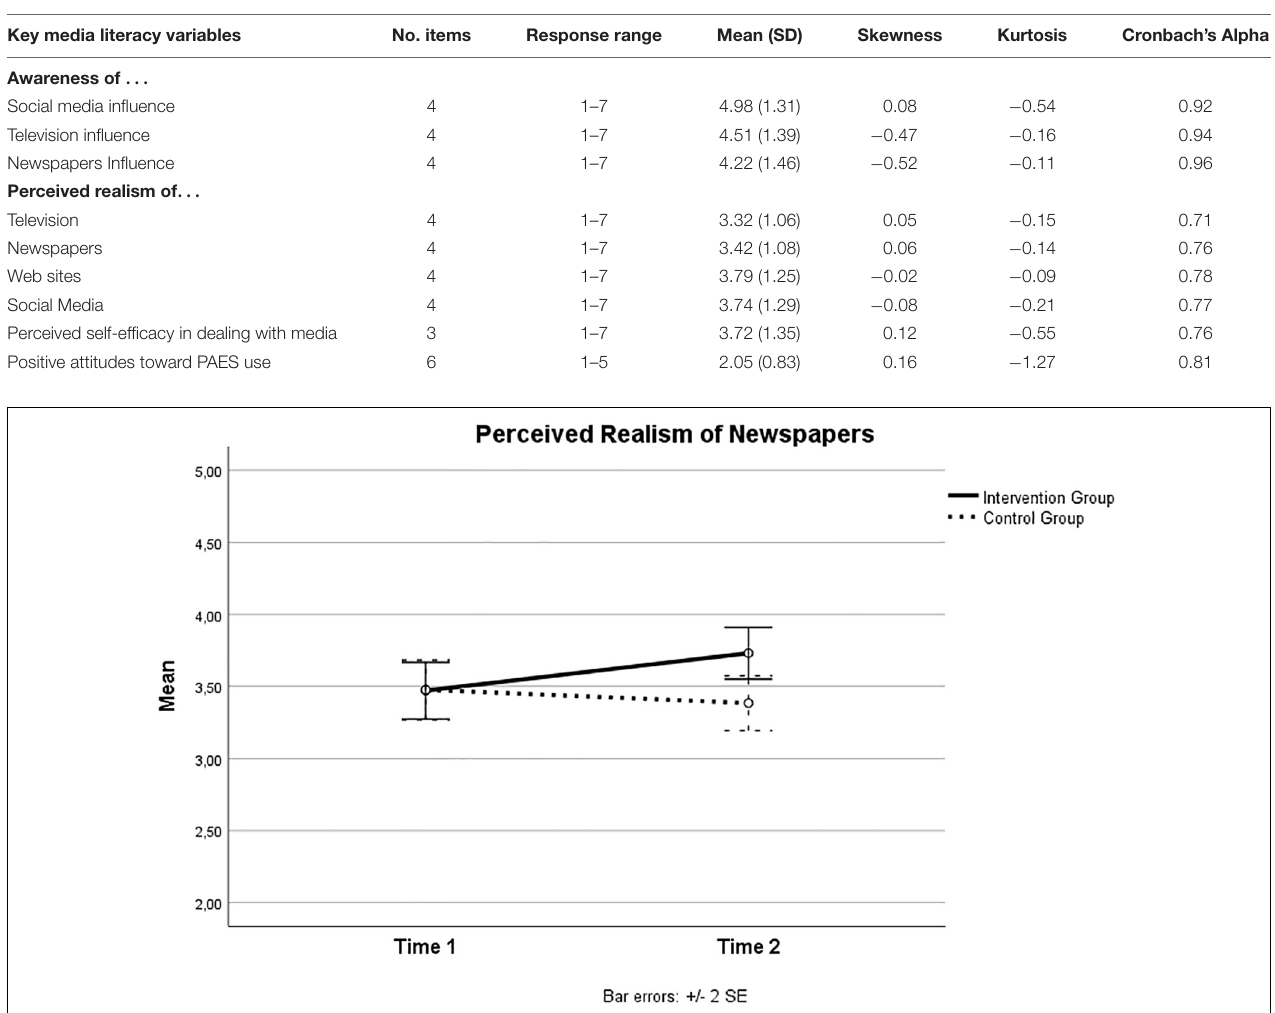
FIGURE 1 | Perceived realism of newspaper across time in intervention and control